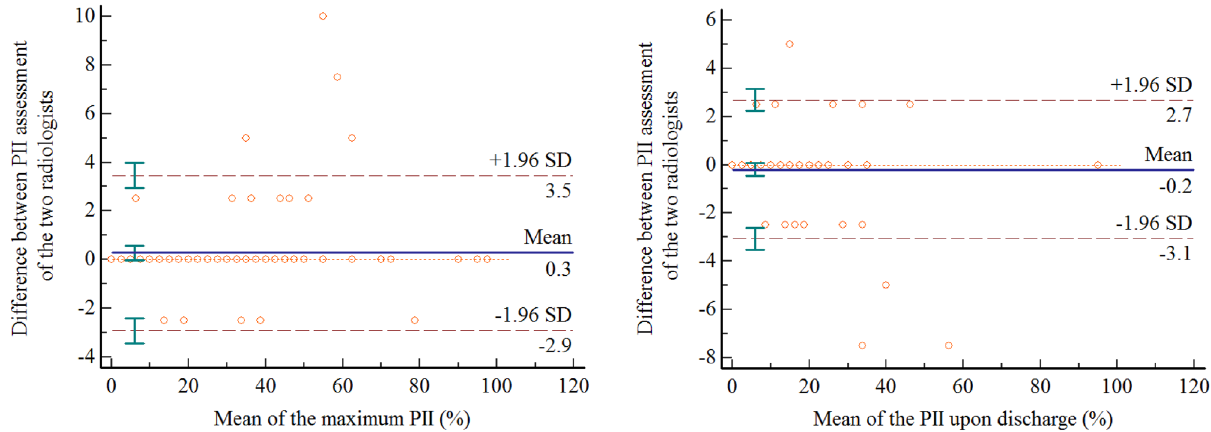
Figure 3. The reliability of quantitative methods for PII between Radiologist 1 and Radiologist 2. The left hand panel depicts the Bland–Altman plot of the two radiologists assessed the maximum PII. The right hand panel depicts the Bland–Altman plot of the two radiologists assessed the PII upon discharge. The upper and lower dashed lines represented the 95% confidence